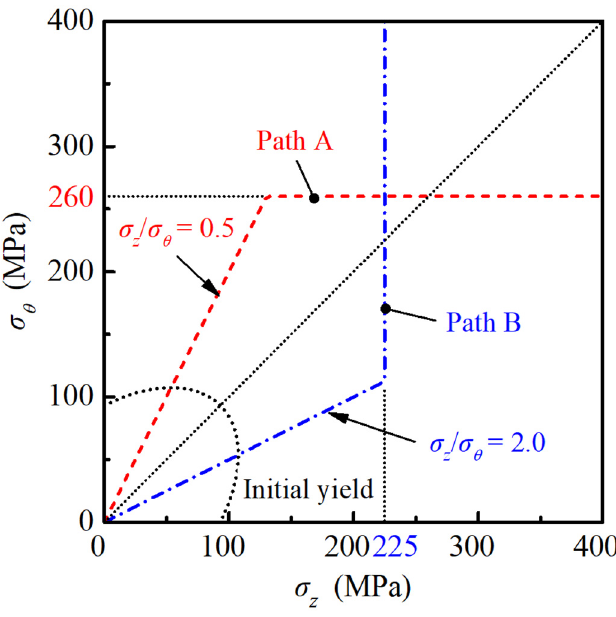
Figure 5. Designed continuous nonlinear loading paths for the AA6061 tube.